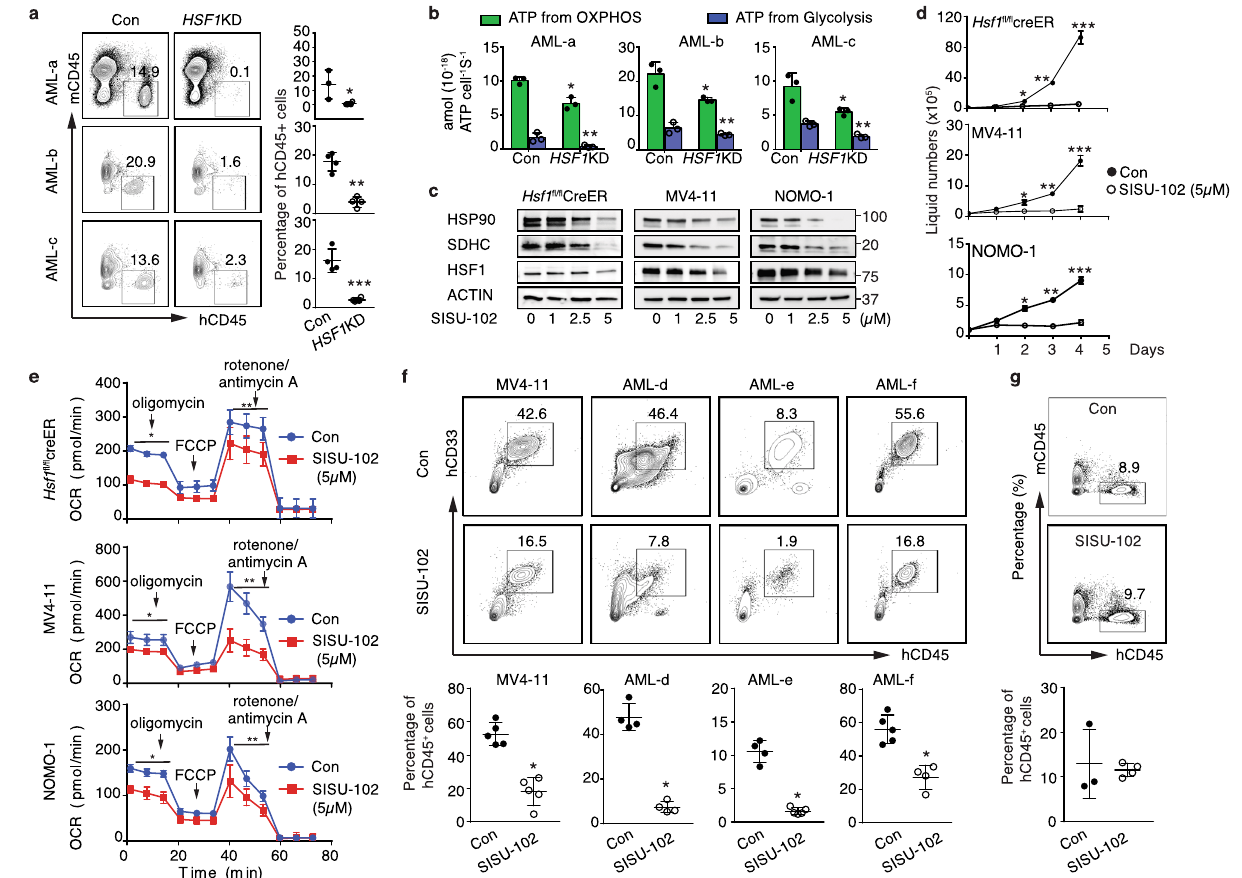
Fig. 7 | HSF1 is critical for maintenance of LSC self-renewal. a Engraftment of three different primary AML LSCs in the presence or absence of CRISPR-mediated HSF1 KD (started 4 mice/AML). * p =0.0404, ** p =0.0003, *** p =0.0006. b ATP production in control or HSF1 knockdown AML cells (post-transplantation from a ) measured by Seahorse assay ( n =3 independent replicates). AML-a: * p =0.0046. ** p =0.0349; AML-b: * p =0.0201. ** p =0.0124; AML-c: * p =0.0325. ** p =0.0033; c The expression of HSP90, SDHC, and HSF1 proteins in SISU-102 treated mouse MLL-AF9 cells and the human AML cell lines MV4 – 11 and NOLM-1 ( n =3 indepen- dent replicates).ACTIN isused asa load control. d Cellgrowth of murine MLL-AF9 cells(* p =1.6×10 − 5 ,** p =3.1×10 − 5 ,*** p =6.1×10 − 5 )andhumanAMLcelllineMV4 – 11 (* p =4.8×10 − 3 ,** p =2.3×10 − 4 ,*** p =1.6×10 − 4 )andNOLM-1(* p =6.3×10 − 4 ,** p =3.01 × 10 − 5 , *** p =6.38 × 10 − 5 ) in the presence of absence of SISU-102 ( n =3